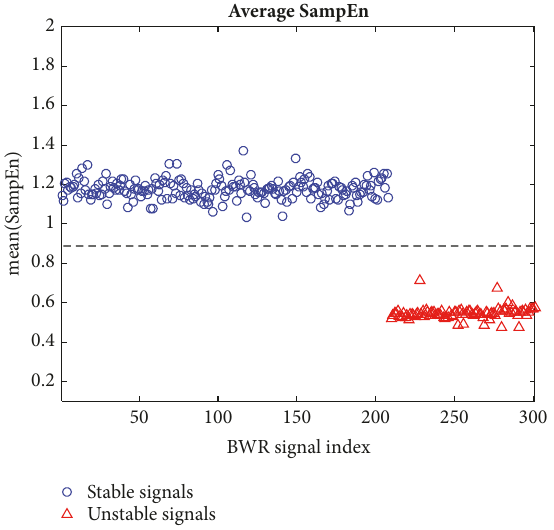
Figure 16: Comparison of the mean(SampEn) values for both studied sets (a stable set of 208 APRM signals versus an unstable set of 96 LPRM signals).